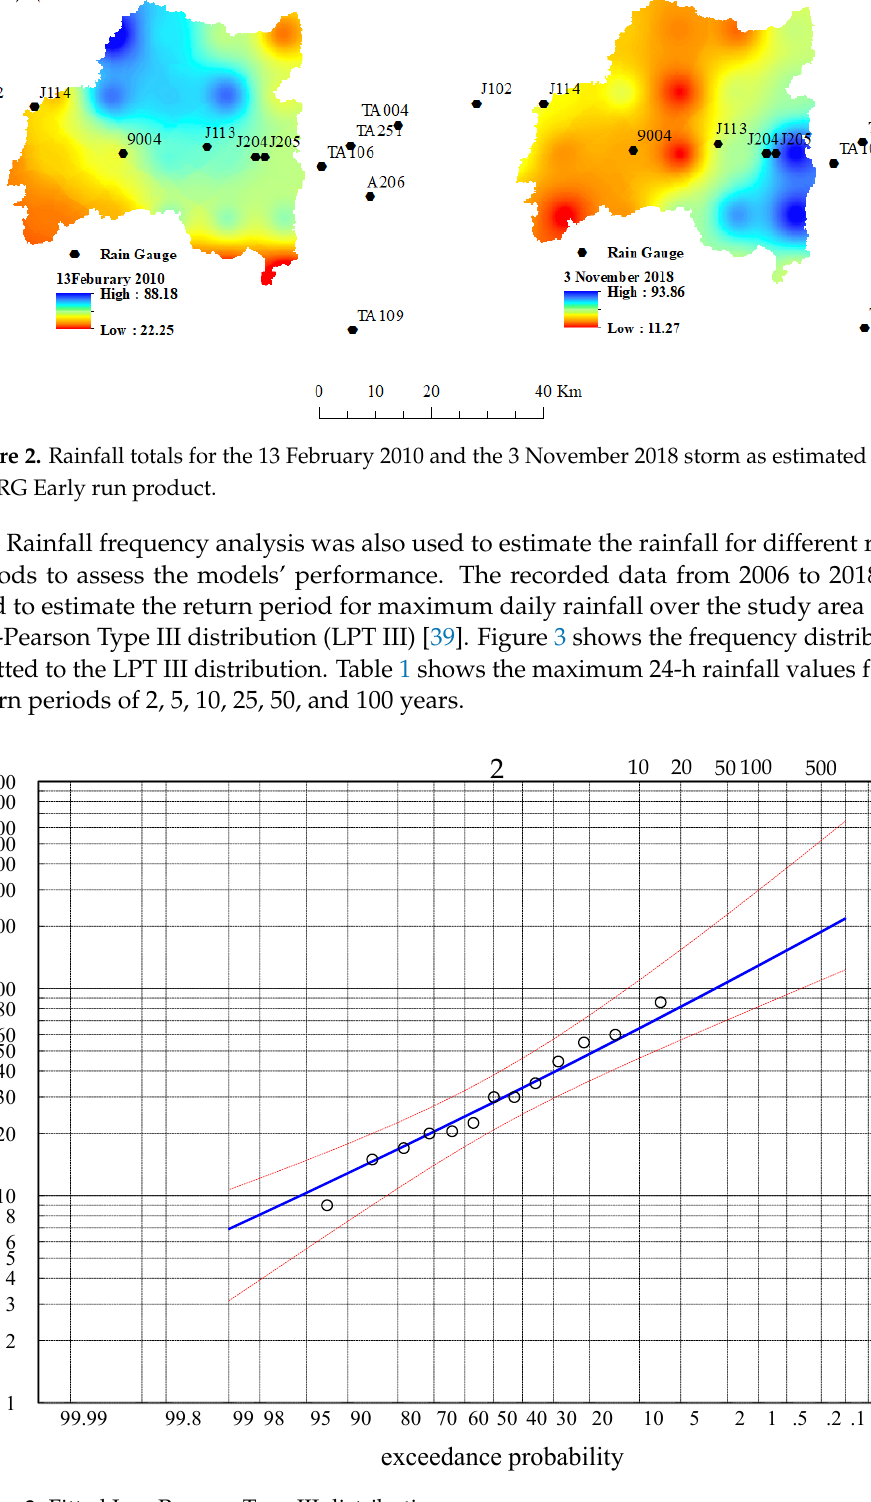
Figure 3. Fitted Log-Pearson Type III distribution.